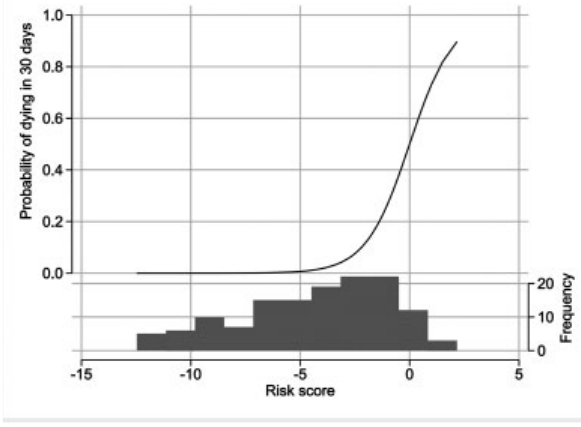
Coefficient Standard error